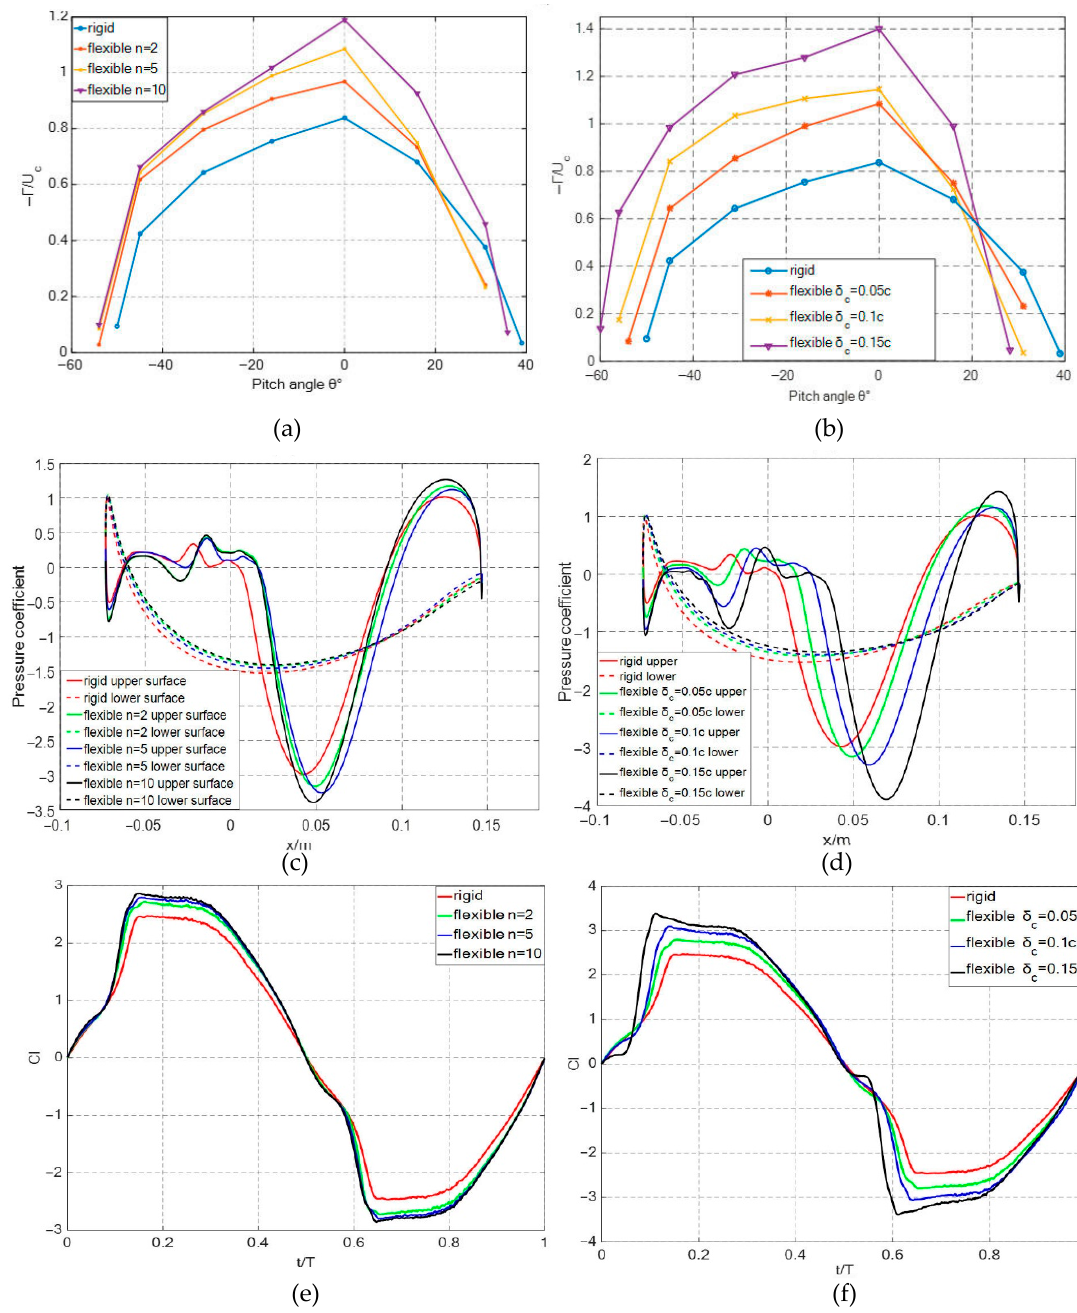
Figure 11. ( a, b ) Comparison of with different pitch angles at f * = 0.13. ( c, d ) Comparison of the pressure Figure 11. ( a , b ) Comparison of − Γ / U c with different pitch angles at f * = 0.13. ( c , d ) Comparison of the coefficient of the hydrofoil surface with = 0 at f * = 0.13. ( e, f ) Comparison of lift coefficient with different chord- pressure coefficient of the hydrofoil surface with θ = 0 at f * = 0.13. ( e , f ) Comparison of lift coefficient with different chord-wise flexible hydrofoils at f * = 0.13. Here, ( a , c , e ) Fixed δ c = 0.05 c , ( b , d , f ) Fixed n = wise flexible hydrofoils at f * = 0.13. Here, ( a, c, e ) Fixed δ c = 0.05 c , ( b, d, f ) Fixed n = 5.